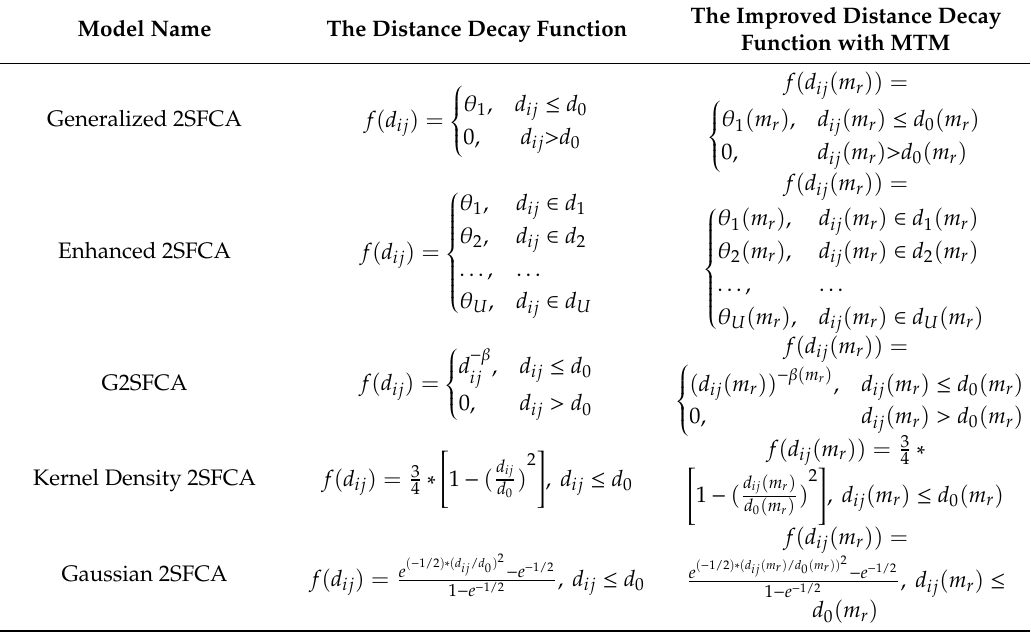
Table 4. List of MTM-RTMC mechanisms improving the distance decay function of five 2SFCA models. Model